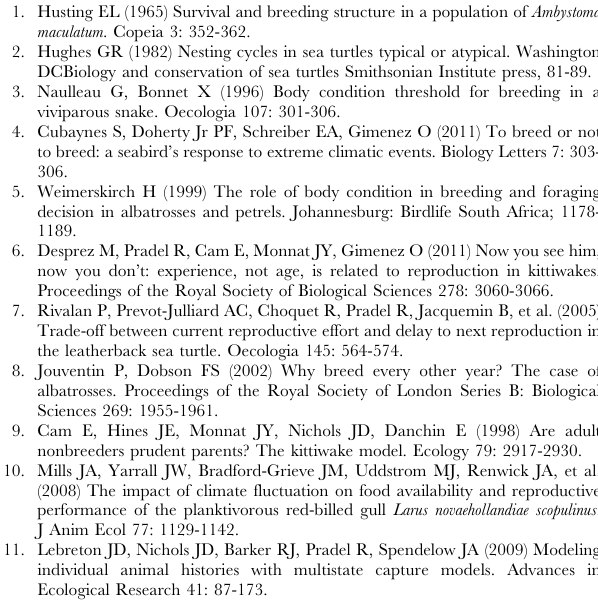
Table S2 Estimates of demographic parameters and detection probability from models incorporating ob- servable non-breeders or not in the constant